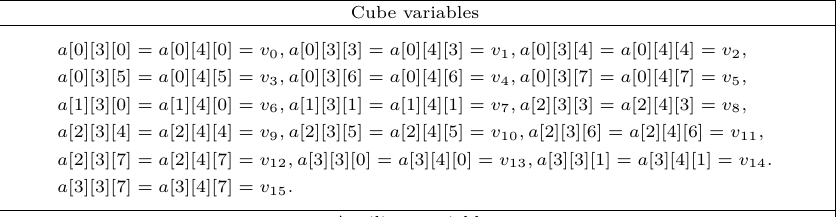
Table 8: The third 16-dimensional cubes for Ketje Jr V1, where the corresponding ( n a , n i ) is (26 , 27) and ( n 0 , n 0 ) is (4 , 16). The accumulated number of key bits recovered is a i 74.